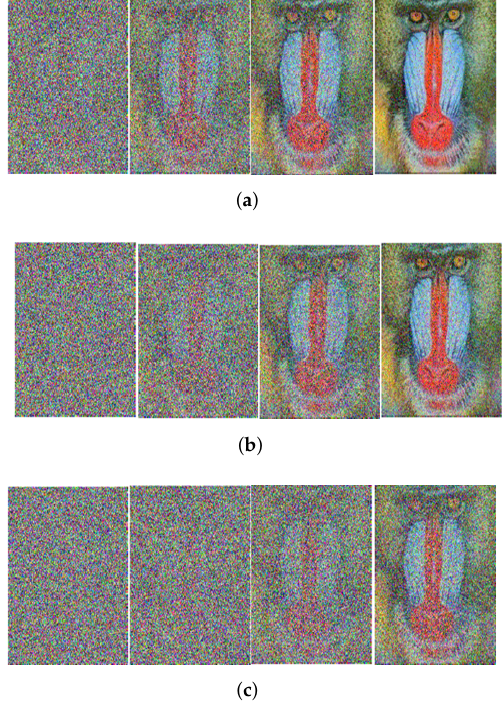
Figure 8. Received image with massive MIMO incorporated FFT-OFDM over a Rayleigh channel, Modulated with 32-PSK and at SNR = 0, 10, 20, 30 dB from Left to Right for different number of users, n . ( a ) n = 10; ( b ) n = 20; ( c ) n = 50.